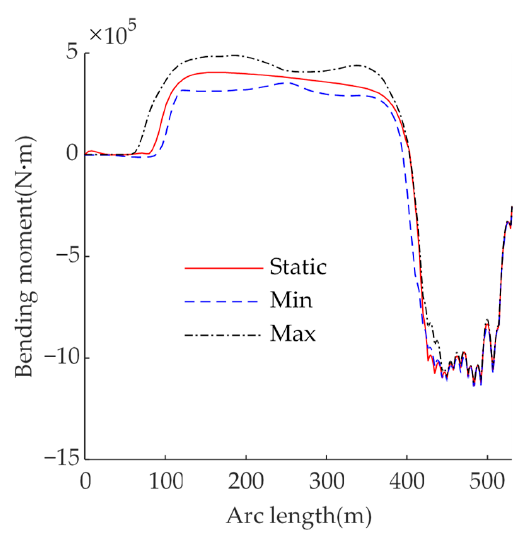
Figure 17. Comparison of bending moments.